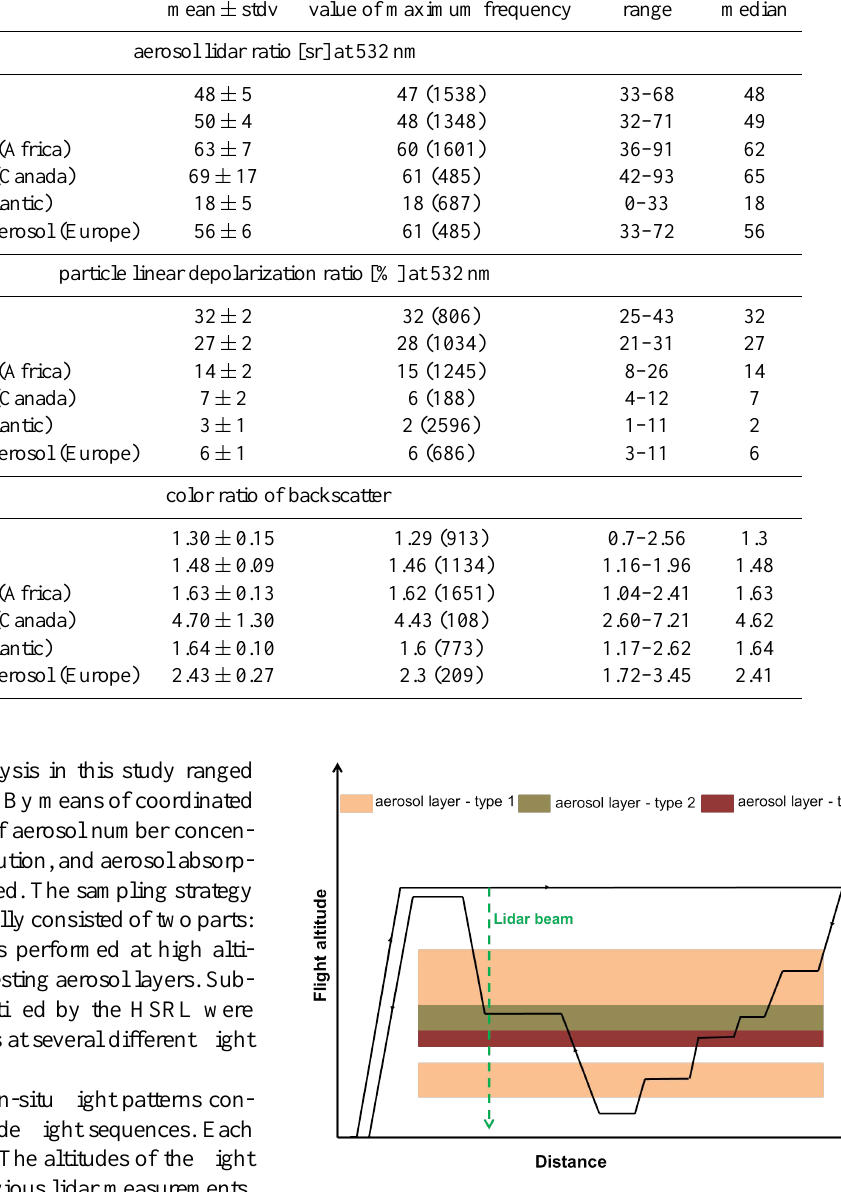
Fig. 2. Flight strategy for coordinated remote sensing and in-situ